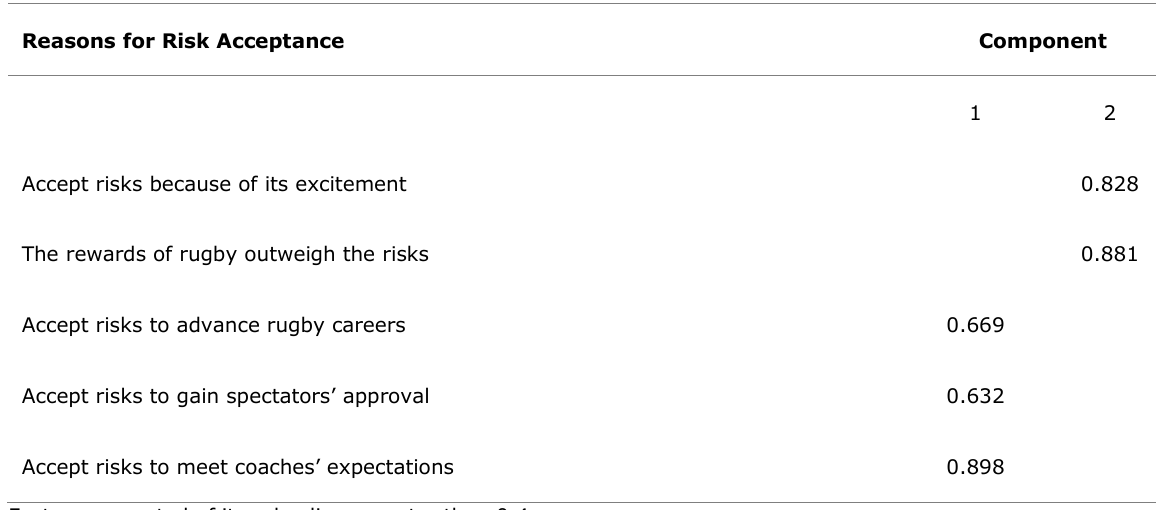
Table 9 . Section 8 Rotated Component